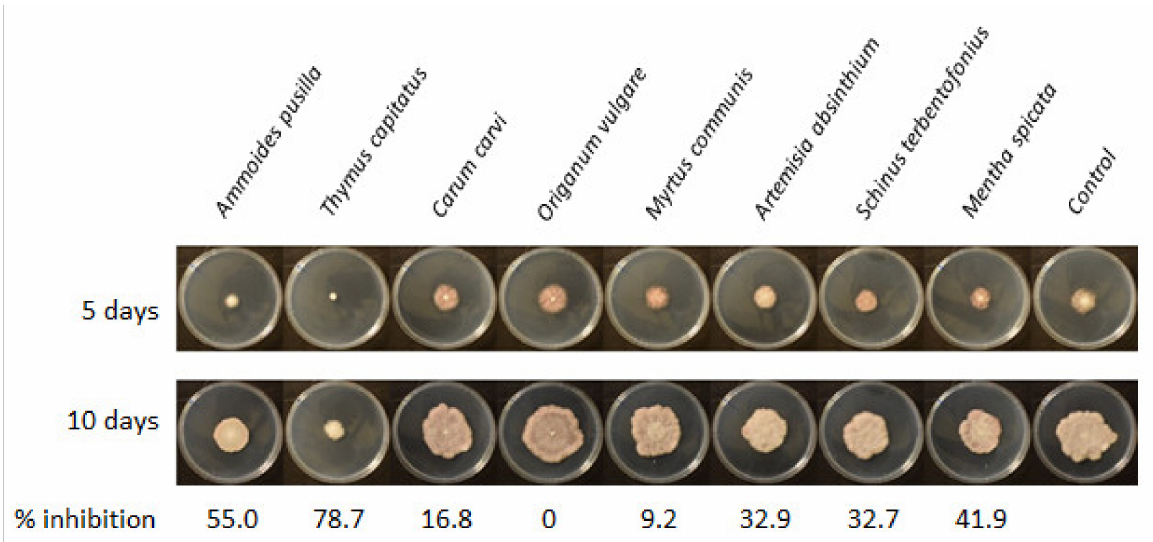
Figure 5. Susceptibility of F. acuminatum 33T to the antifungal activity of a set of essential oils from eight Tunisian plants diluted at 0.1 µ L mL − 1 in FDM-agar, incubated at 25 ◦ C for 10